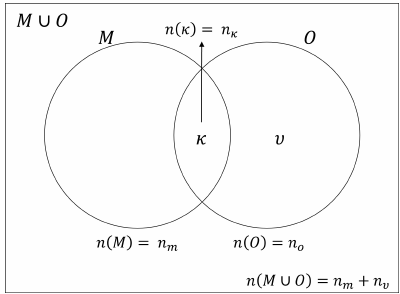
Figure 3. Classification of landmarks.